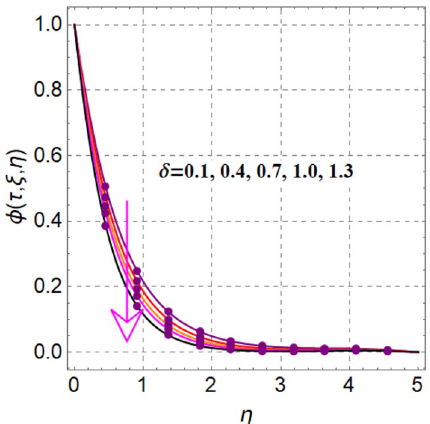
Figure 8. φ(τ , ξ , η) via δ .